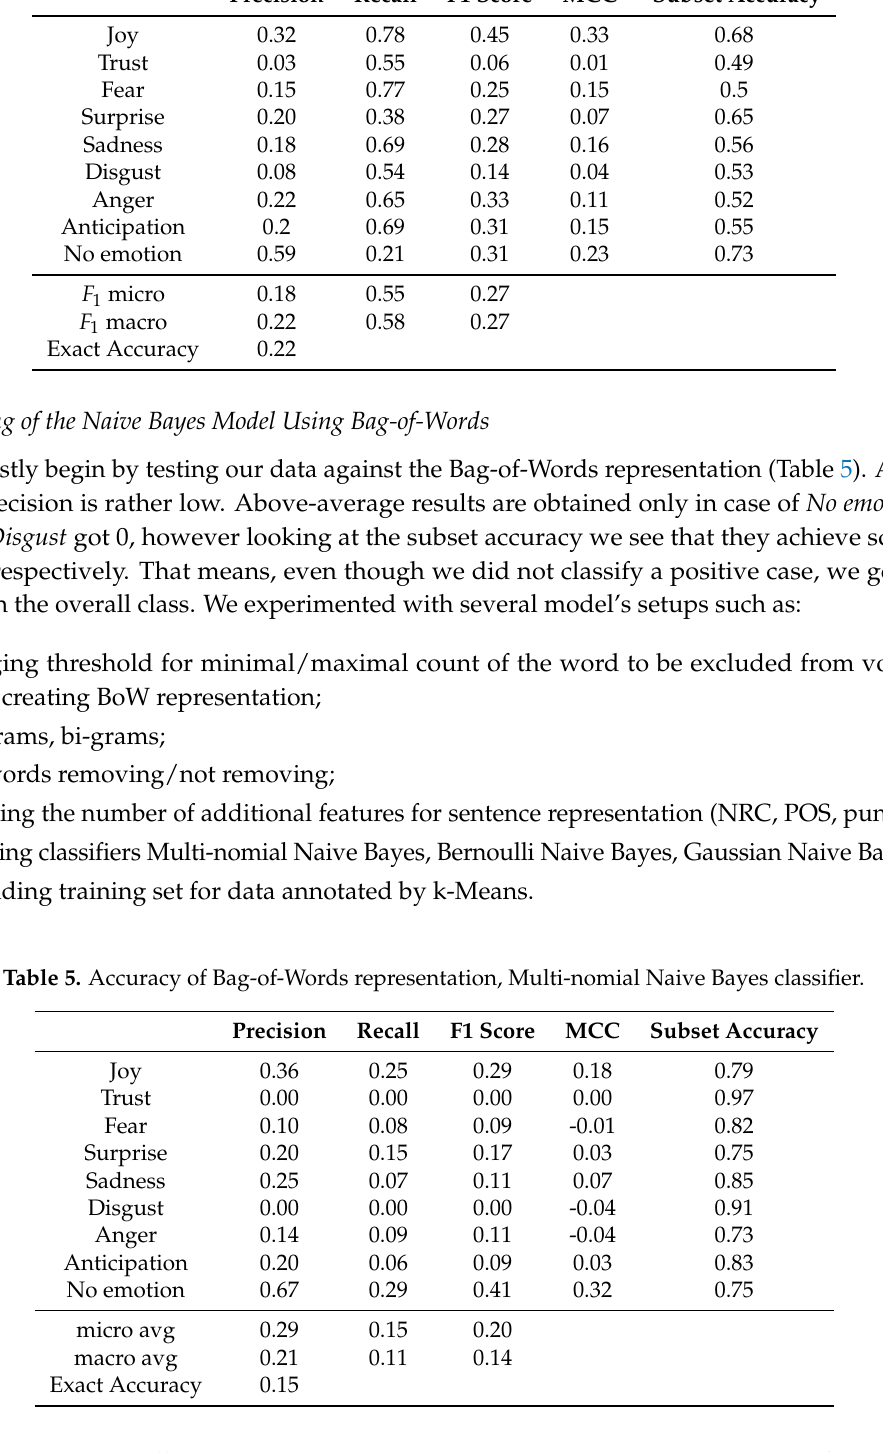
Table 4. Accuracy of emotion dictionary, lexicon approach. Precision Recall F1 Score MCC Subset Accuracy